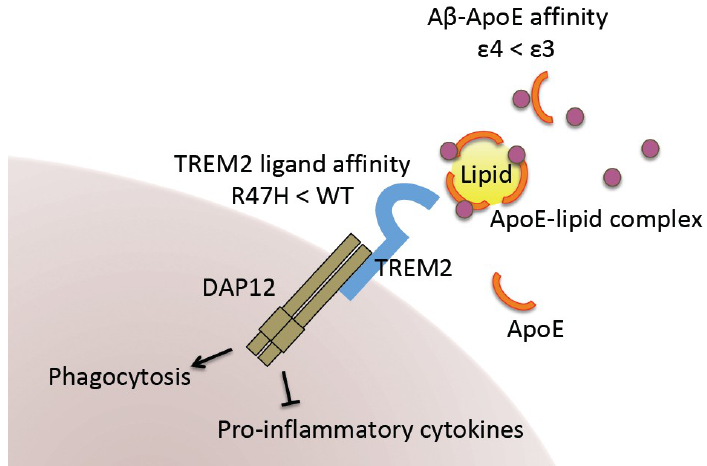
Figure 2. Impact of APOE4 and TREM2 R47H variants on AD pathology. Lipidated ApoE binds Aβ for its internalization or transport to other cell types. ApoE4 exhibits lower Aβ-binding affinity than ApoE3. TREM2 in microglia mediates ApoE-driven Aβ clearance. It is also required for microglial phagocytosis and inhibition of the immune response. The genetic variant on this gene ( TREM2 R47H) has been shown to exhibit lower ligand-binding affinity.